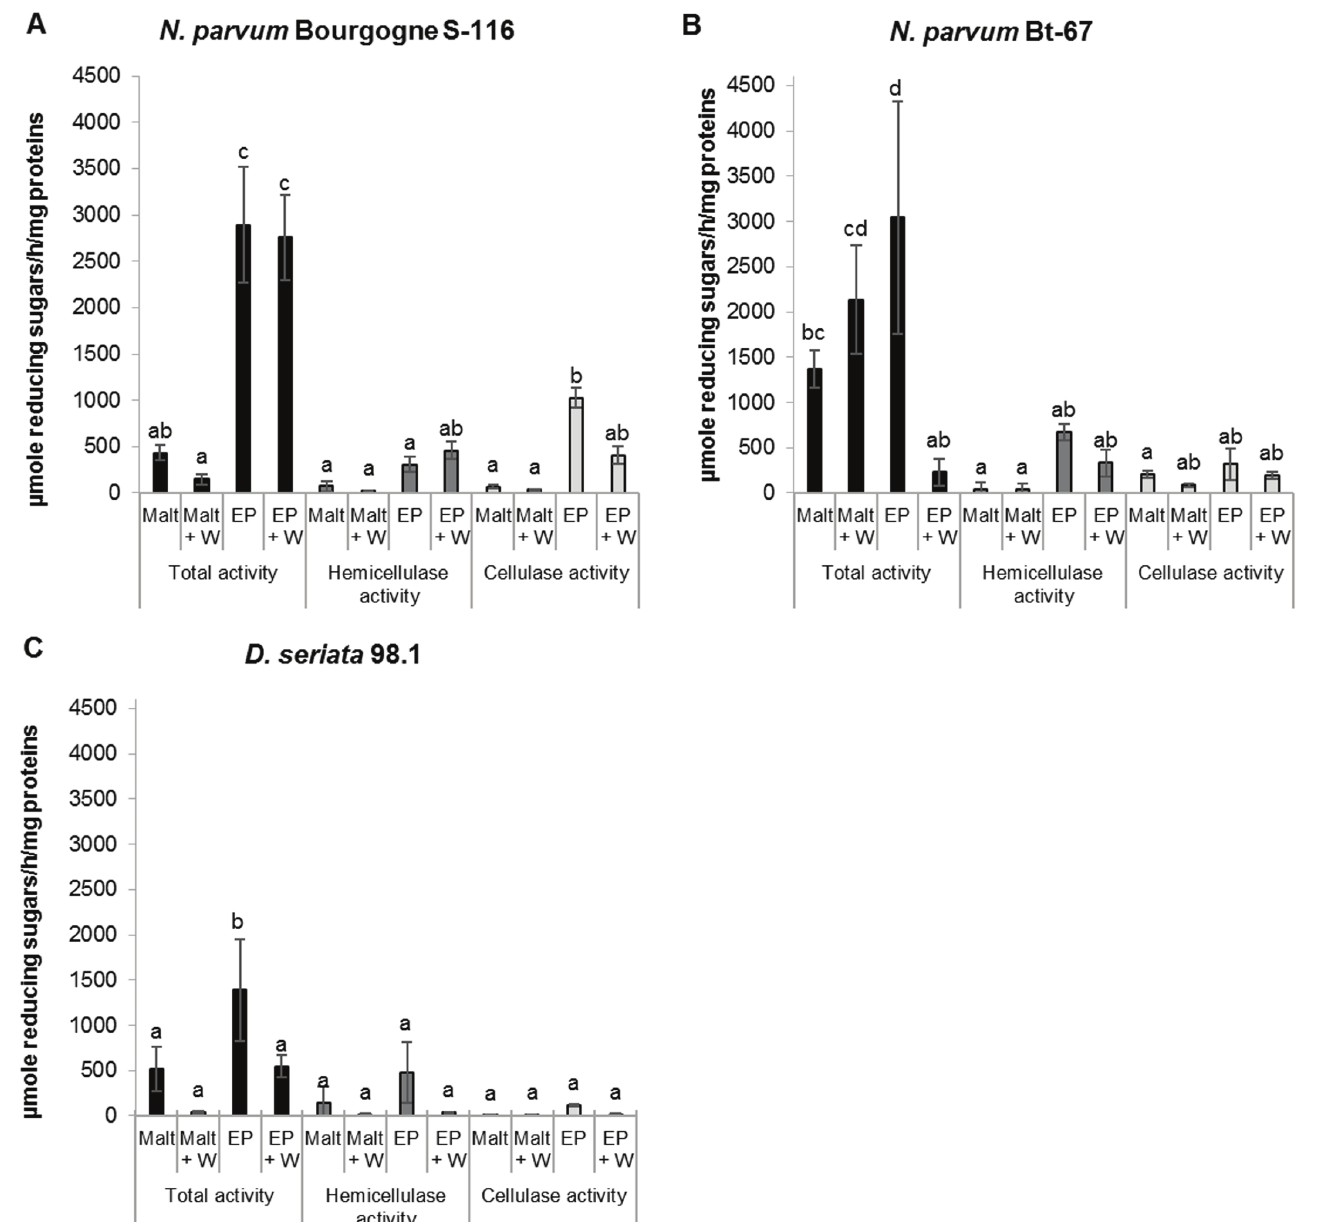
Fig 1. Polysaccharide degrading enzymatic activities. Glucose liberationresulting from cellulase,hemicellulase and total activities of secreted proteins from N . parvum BourgogneS-116 (A), N . parvum Bt-67 (B) and D . seriata 98.1 (C), was measuredwith a colorimetric method using dinitrosalicylic acid (DNS). Total proteins were isolated from culture filtrates of fungi grown in liquidmalt medium (Malt), malt medium supplemented with V . vinifera sawdust (Malt + W), Erickson and Peterson medium (EP) and Erickson and Peterson medium supplemented with V . vinifera sawdust (EP + W). Values are means and SD of three biologicalreplicates, each calculatedfrom the mean of three technicalreplicates. Means with a same letter are not significantly different at p (cid:20) 0.05(Tukey Contrasts).